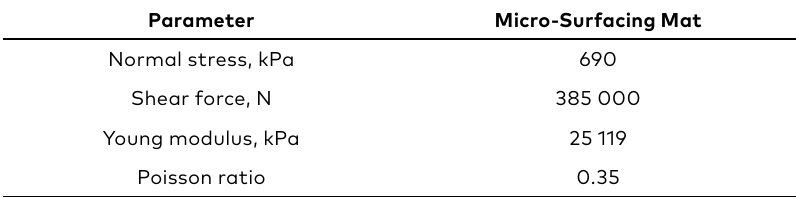
Table 3 Input material properties of Finite Element